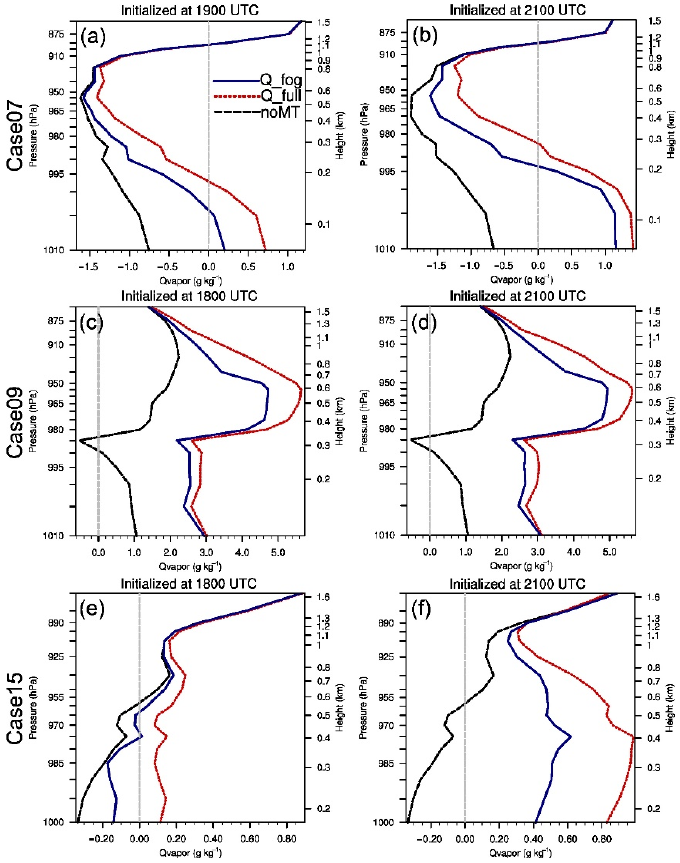
Figure 13. Profiles of biases for water vapor mixing ratio (Qvapor; g kg − 1 ) between forecasts from noMT, Q_full, and Q_fog and sounding observations, respectively, aggregated over specific stations (Figure 1) close to the observed sea fog area. For Case07, the forecasts valid at 0000 UTC 29 April initialized at ( a ) 1900 UTC and ( b ) 2100 UTC 28 April are aggregated over QD and CS stations. For Case09, the forecasts valid at 0000 UTC 10 April initialized at ( c ) 1800 UTC and ( d ) 2100 UTC 9 April, respectively, are aggregated over SH, HZ, and CJ stations. For Case15, the forecasts valid at 0000 UTC 29 March initialized at ( e ) 1800 UTC and ( f ) 2100 UTC 28 March, respectively, are aggregated over RC, DL, DD, OS, QD, and CJ stations.